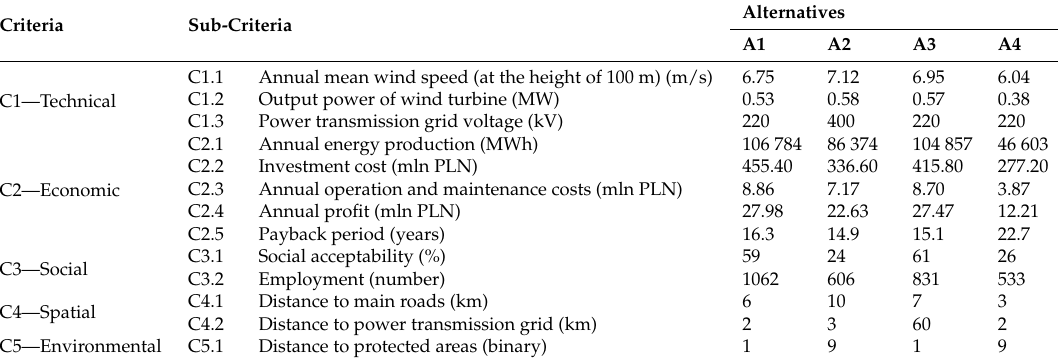
Table 6. Criteria and sub-criteria for evaluating locations and designs of onshore wind farms Criteria